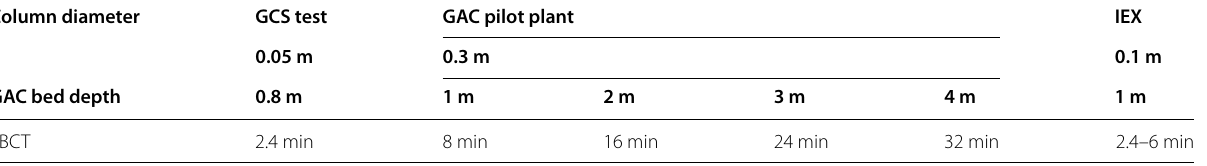
Table 4 Parameters for adsorber design and operation Column